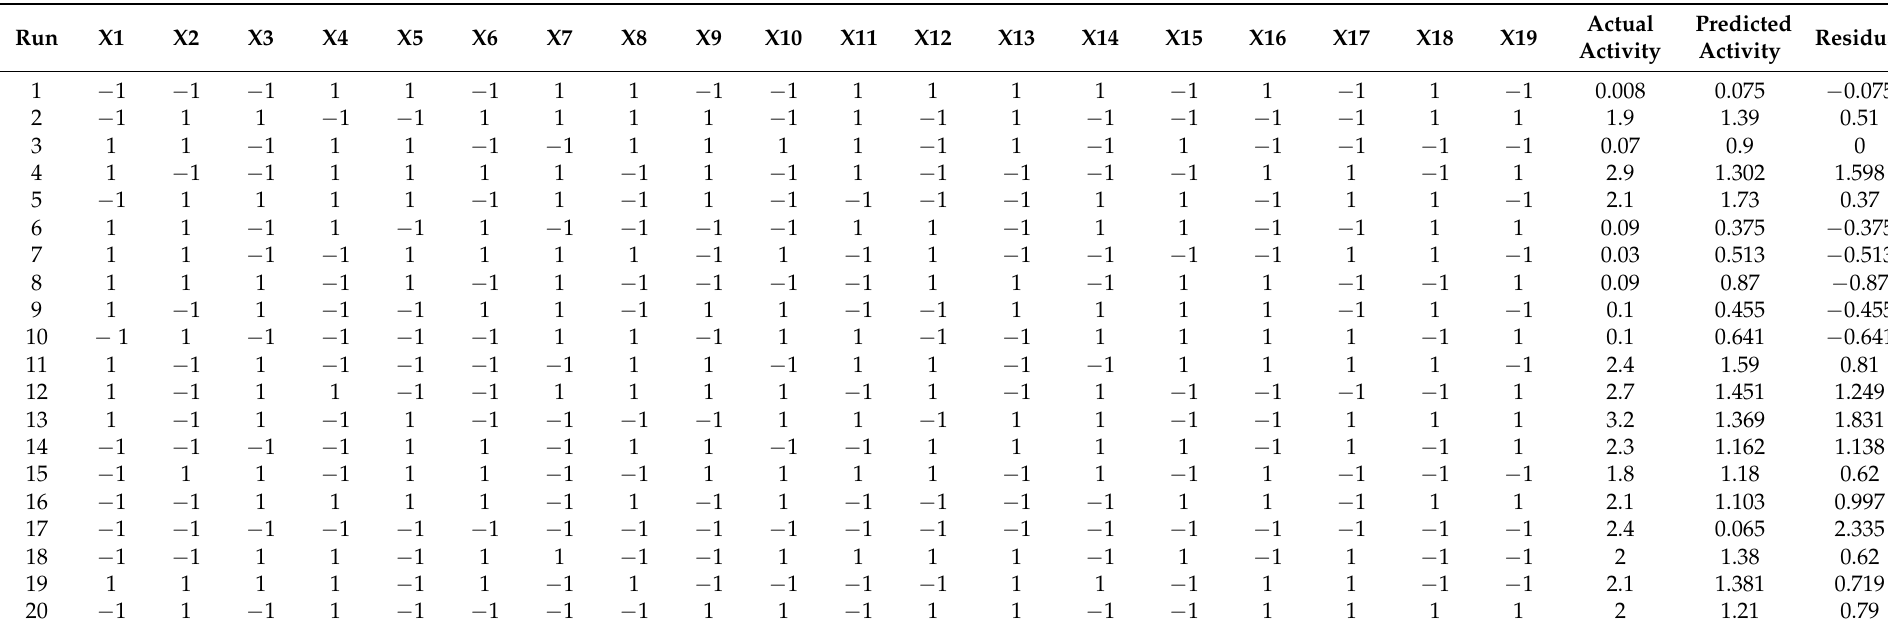
Table 3. Twenty-trial Plackett–Burman experimental design for evaluation of fifteen independent variables with coded values and tyrosinase activity by A. terreus . The “ − 1 (cid:48)(cid:48) sign correspond to the minimum value and the “+1 (cid:48)(cid:48) sign correspond to the maximum value of the input parameter